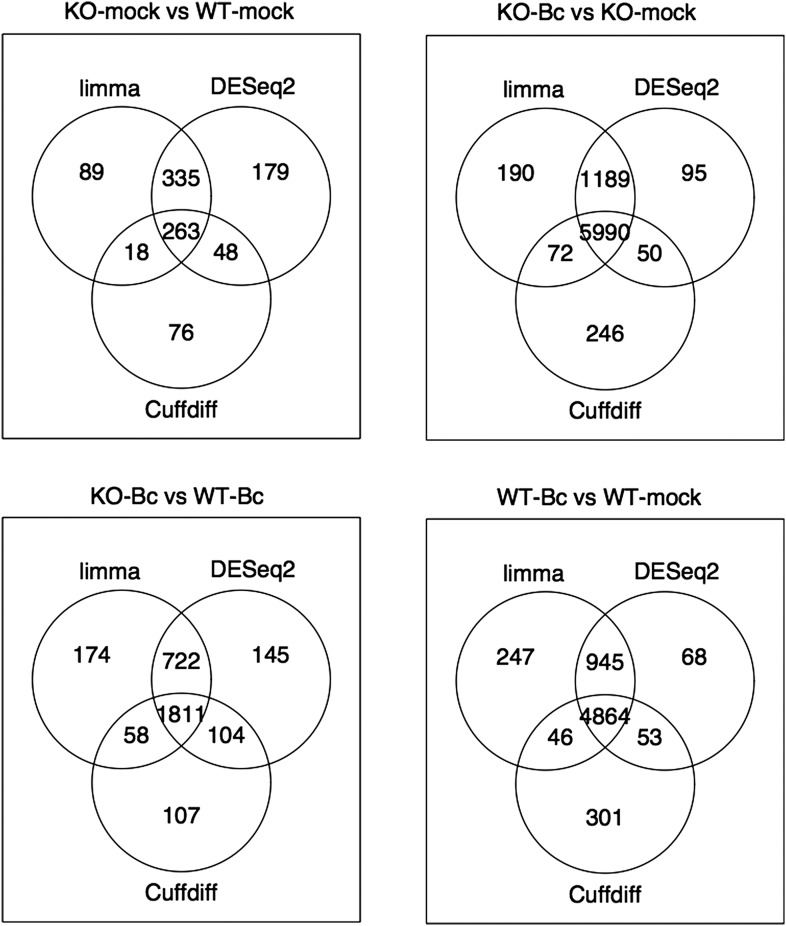
Venn diagrams showing the overlap between the sets of genes identified as significantly differentially expressed (abs(log2FC) ≥ 1, p adj < 0.05) with the three different tools limma (used in our study), DESeq2 and Cuffdiff for the four analysed comparisons.